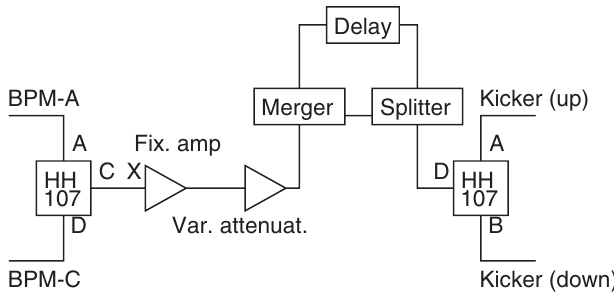
FIG. 6. Circuit of the FEATHER [4] fast intrapulse feedback system.